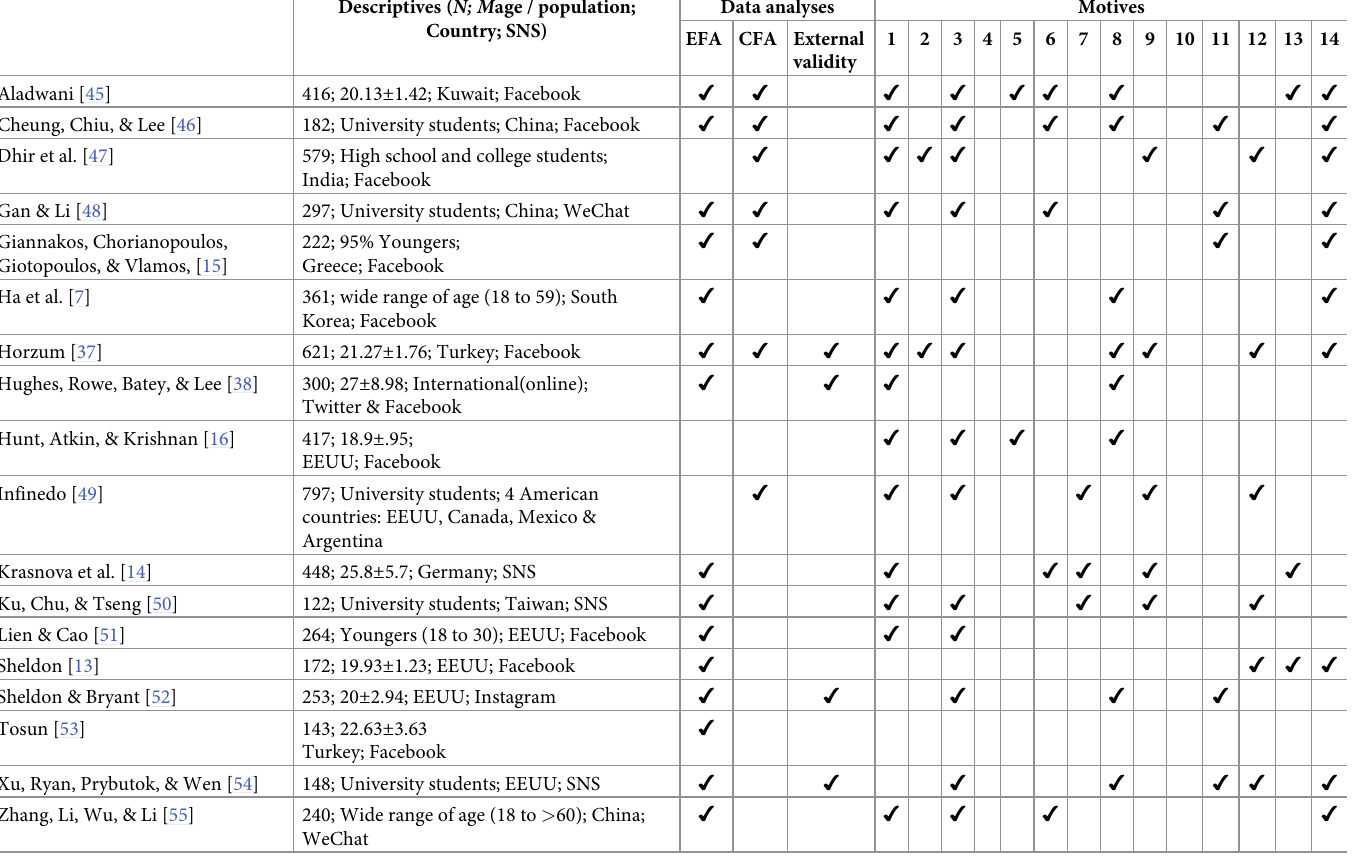
Table 2. Description of the previous studies developing scales to assess motives for using SNS. Descriptives ( N; M age / population; Data analyses Country; SNS)